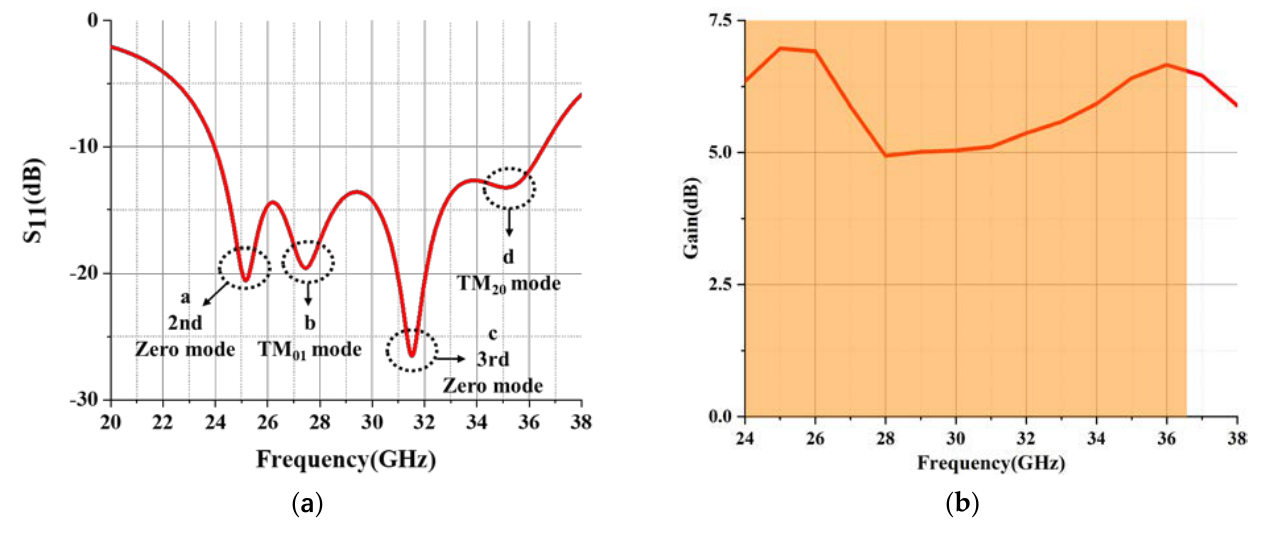
Figure 3. ( a ) The simulated S 11 parameter from ANSYS HFSS. ( b ) The simulated gain from ANSYS HFSS.